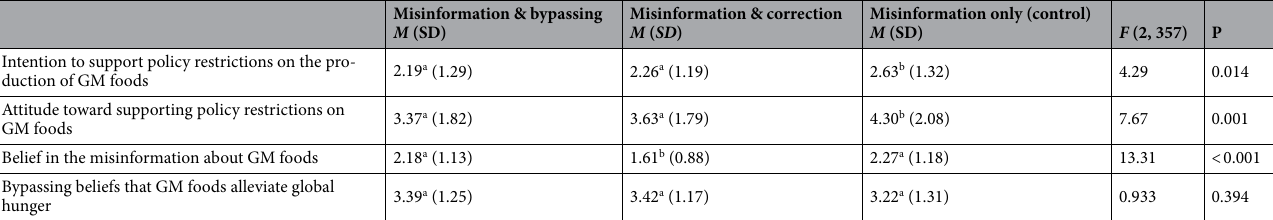
Table 1. Experiment 1 results (N = 360). Different superscripts indicate statistically significant pairwise